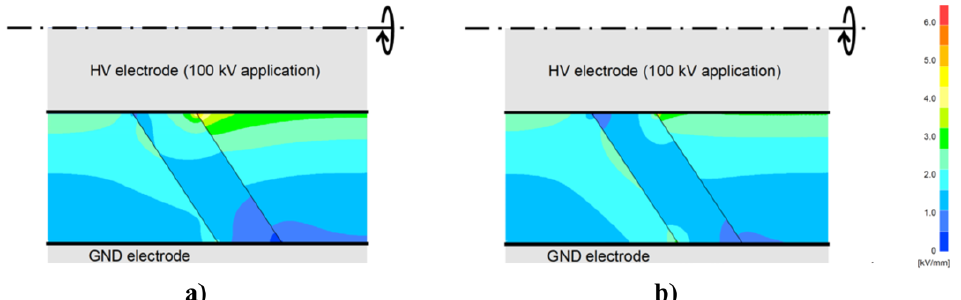
Figure 56. Electric field distribution for a cone-type spacer. ( a ) Uniform spacer, ( b ) FGM spacer. © 2021 IEEE. Reprinted, with permission, from [117].